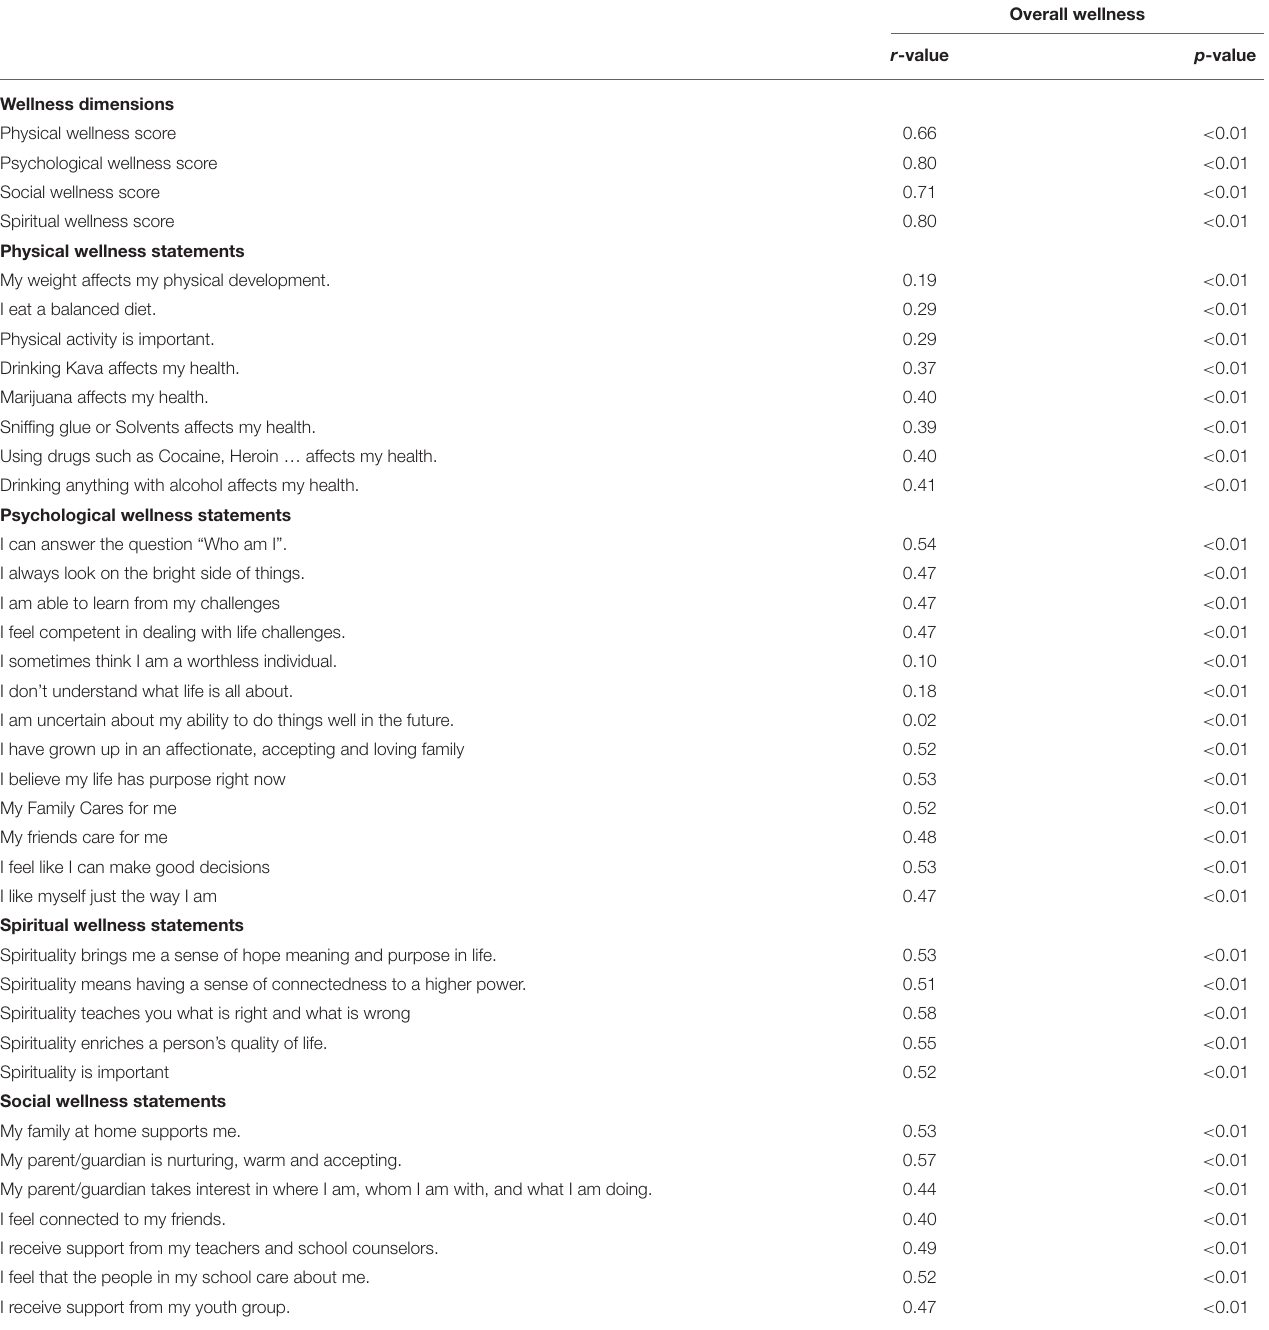
TABLE 4 | Correlations between wellness dimensions, wellness items, and overall wellness.